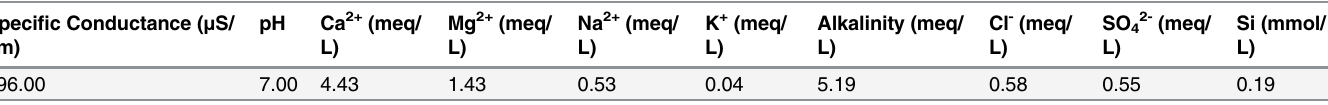
Table 2. Major ions and basic water chemistry of the Edwards Aquifer water used to hold the study mussels in while at the lab. Speci fi c Conductance ( μ